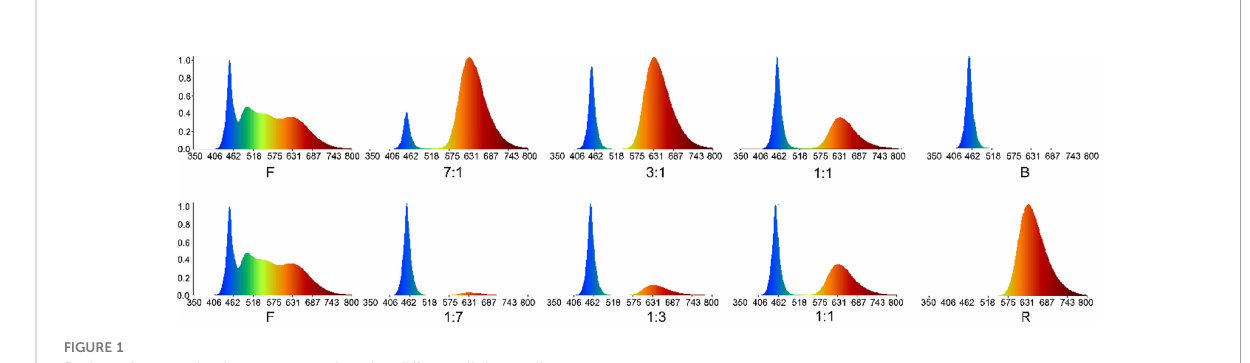
FIGURE 1 Ratios of spectral values measured under different light